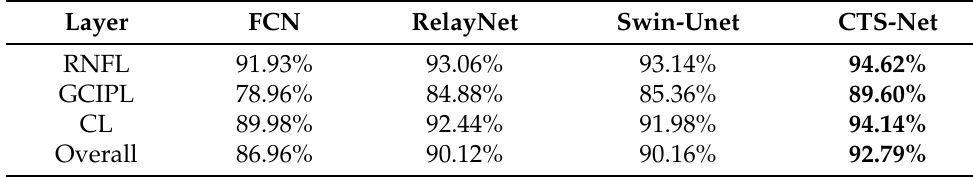
Table 2. Test results of DSC of each method in the GOALS dataset.